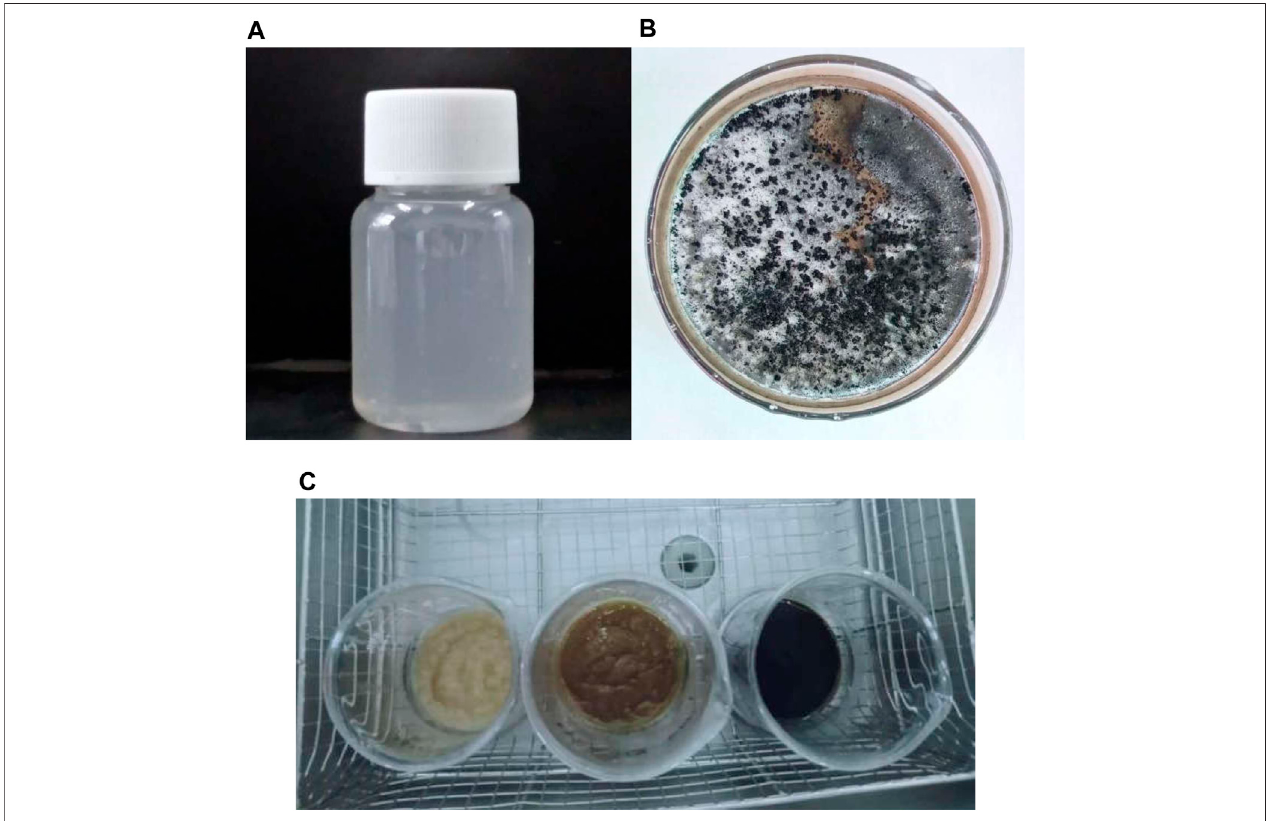
FIGURE 2 | CNC pictures at different treatment conditions: (A) CNC solution (RT); (B) carbonization (70 ° C); (C) color change of the CNC at 55 ° C under different H 2 SO 4 mass fractions (from left to right: 40% wt, 55% wt, and 65%